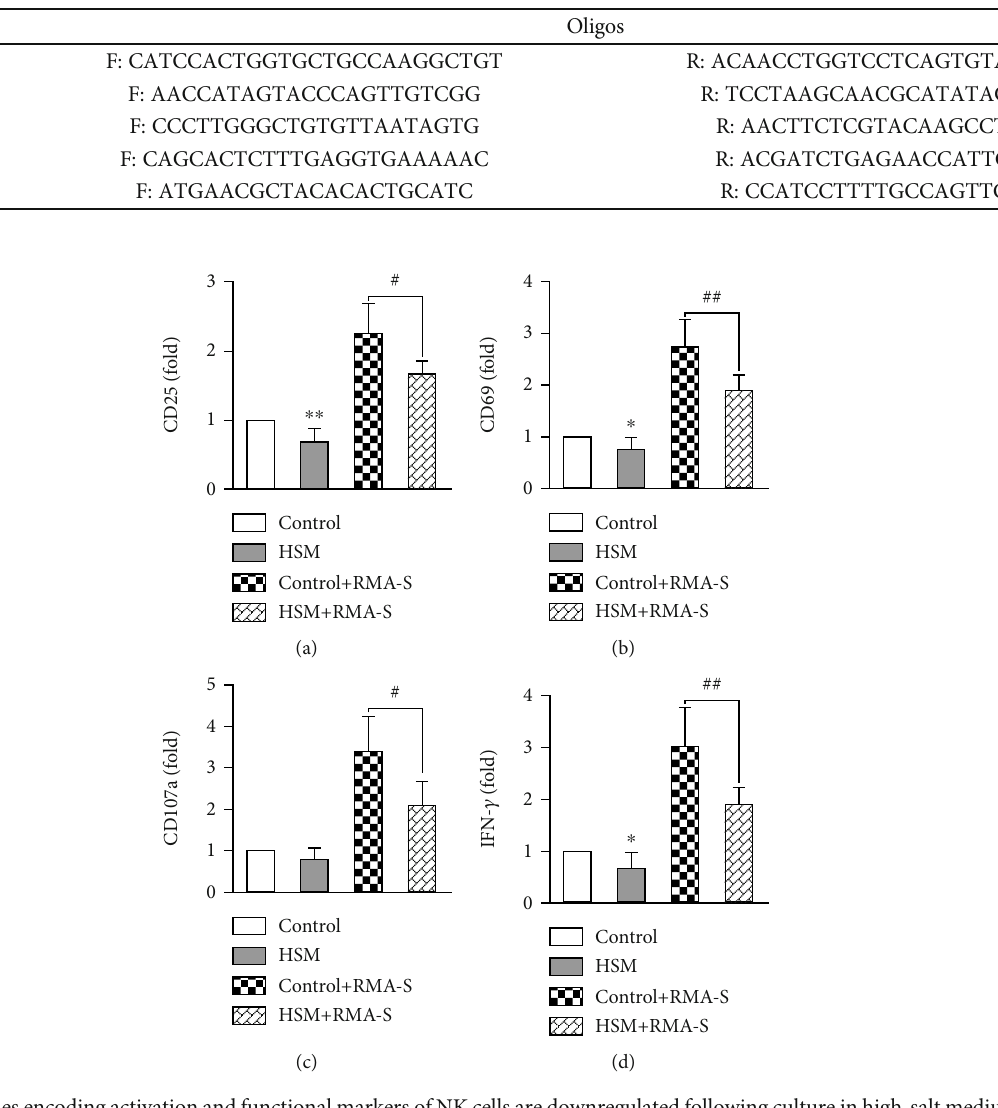
Table 1: Primer sequences used for RT-qPCR.